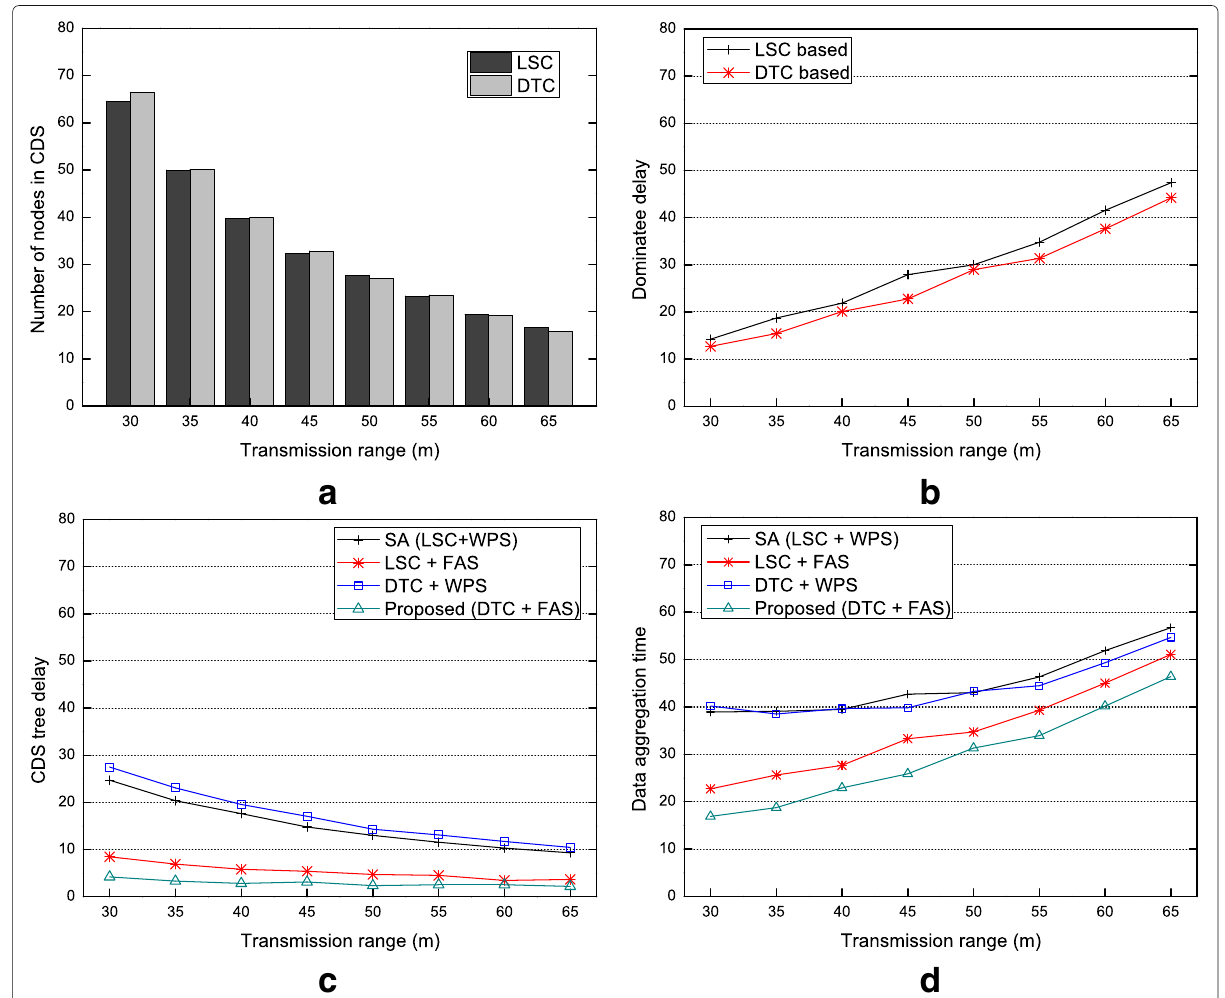
Fig. 7 Performance evaluation with different transmission ranges. a Number of nodes in CDS. b Dominatee aggregation delay. c CDS tree aggregation delay. d Data aggregation